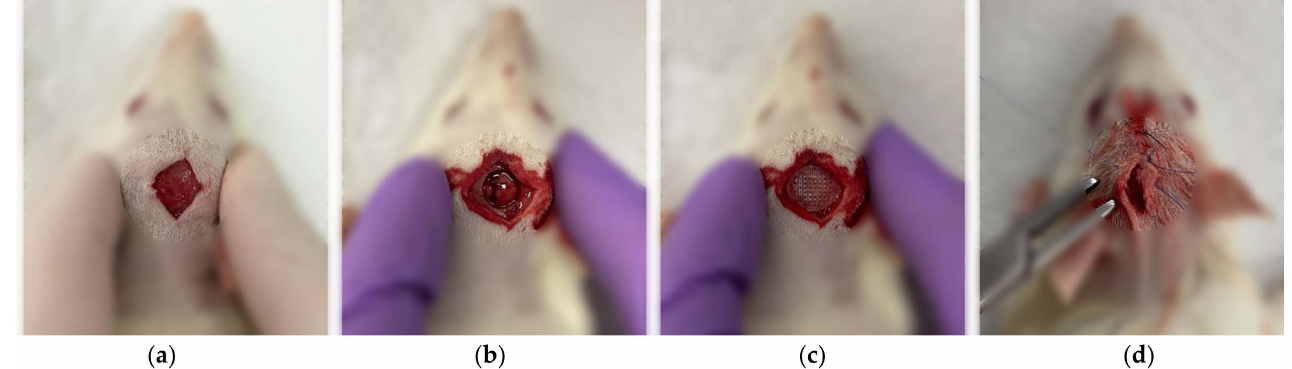
Figure 7. The surgical procedure of the scaffold implantation into the critical-sized cranial defect in rats. ( a ) Skin incision; ( b ) Trephine defect in parietal bone; ( c ) Scaffold positioning; and ( d ) Skin